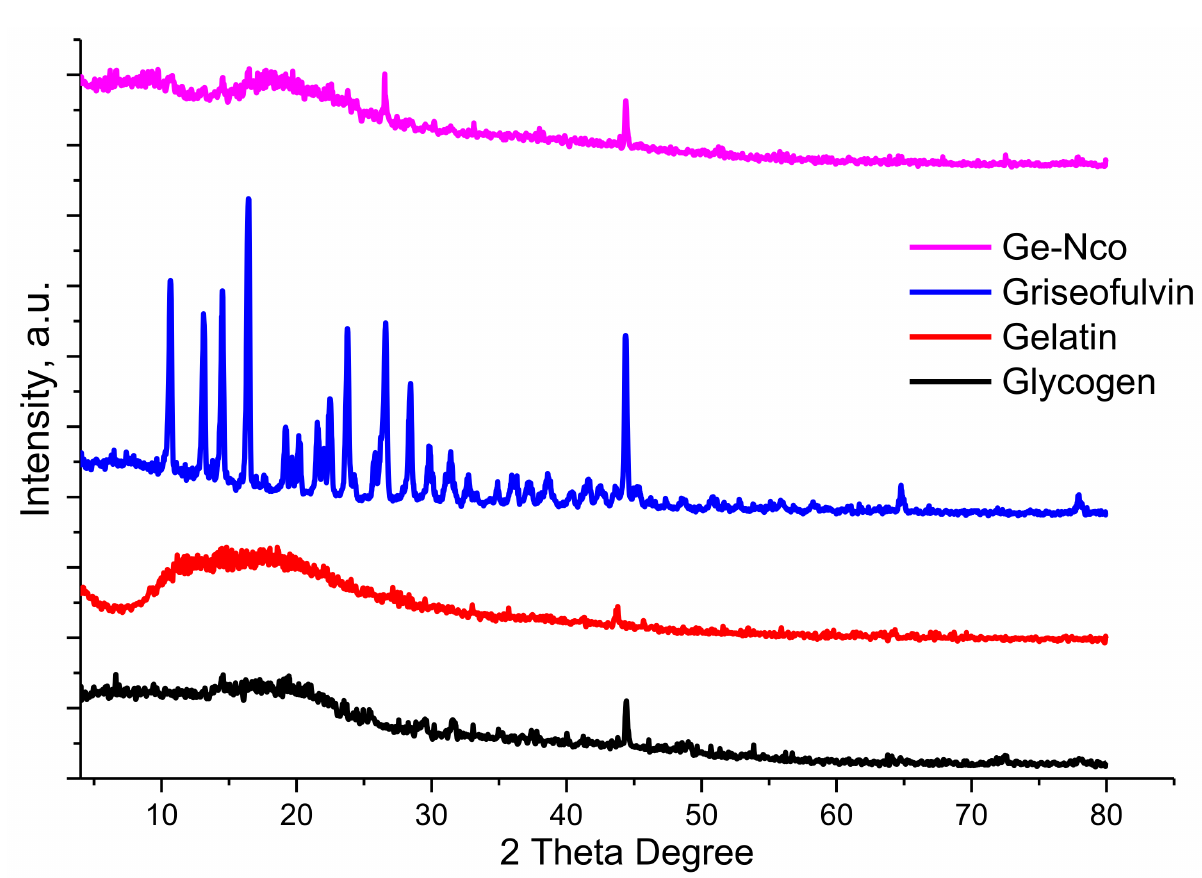
Figure 2. X-ray diffraction of the green nanocomposite-based biopolymers and their raw